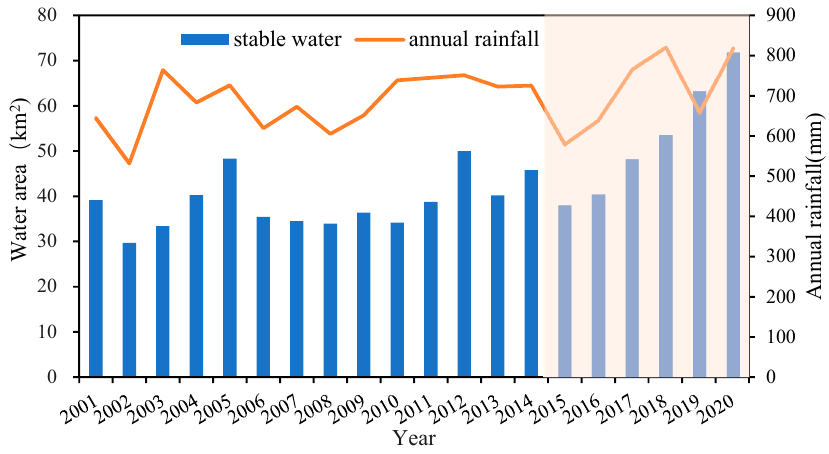
Figure 6. Changes in the stable water area in Zoige county from 2001 to 2020.